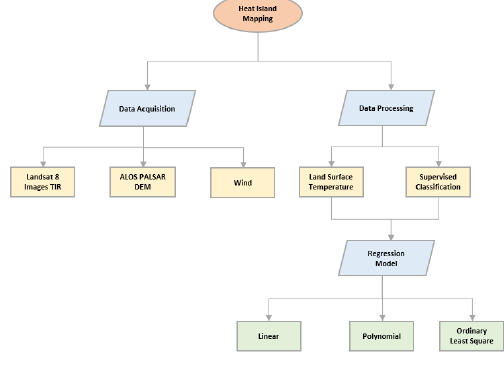
Figure 3: Surface Urban Heat Island Work chart